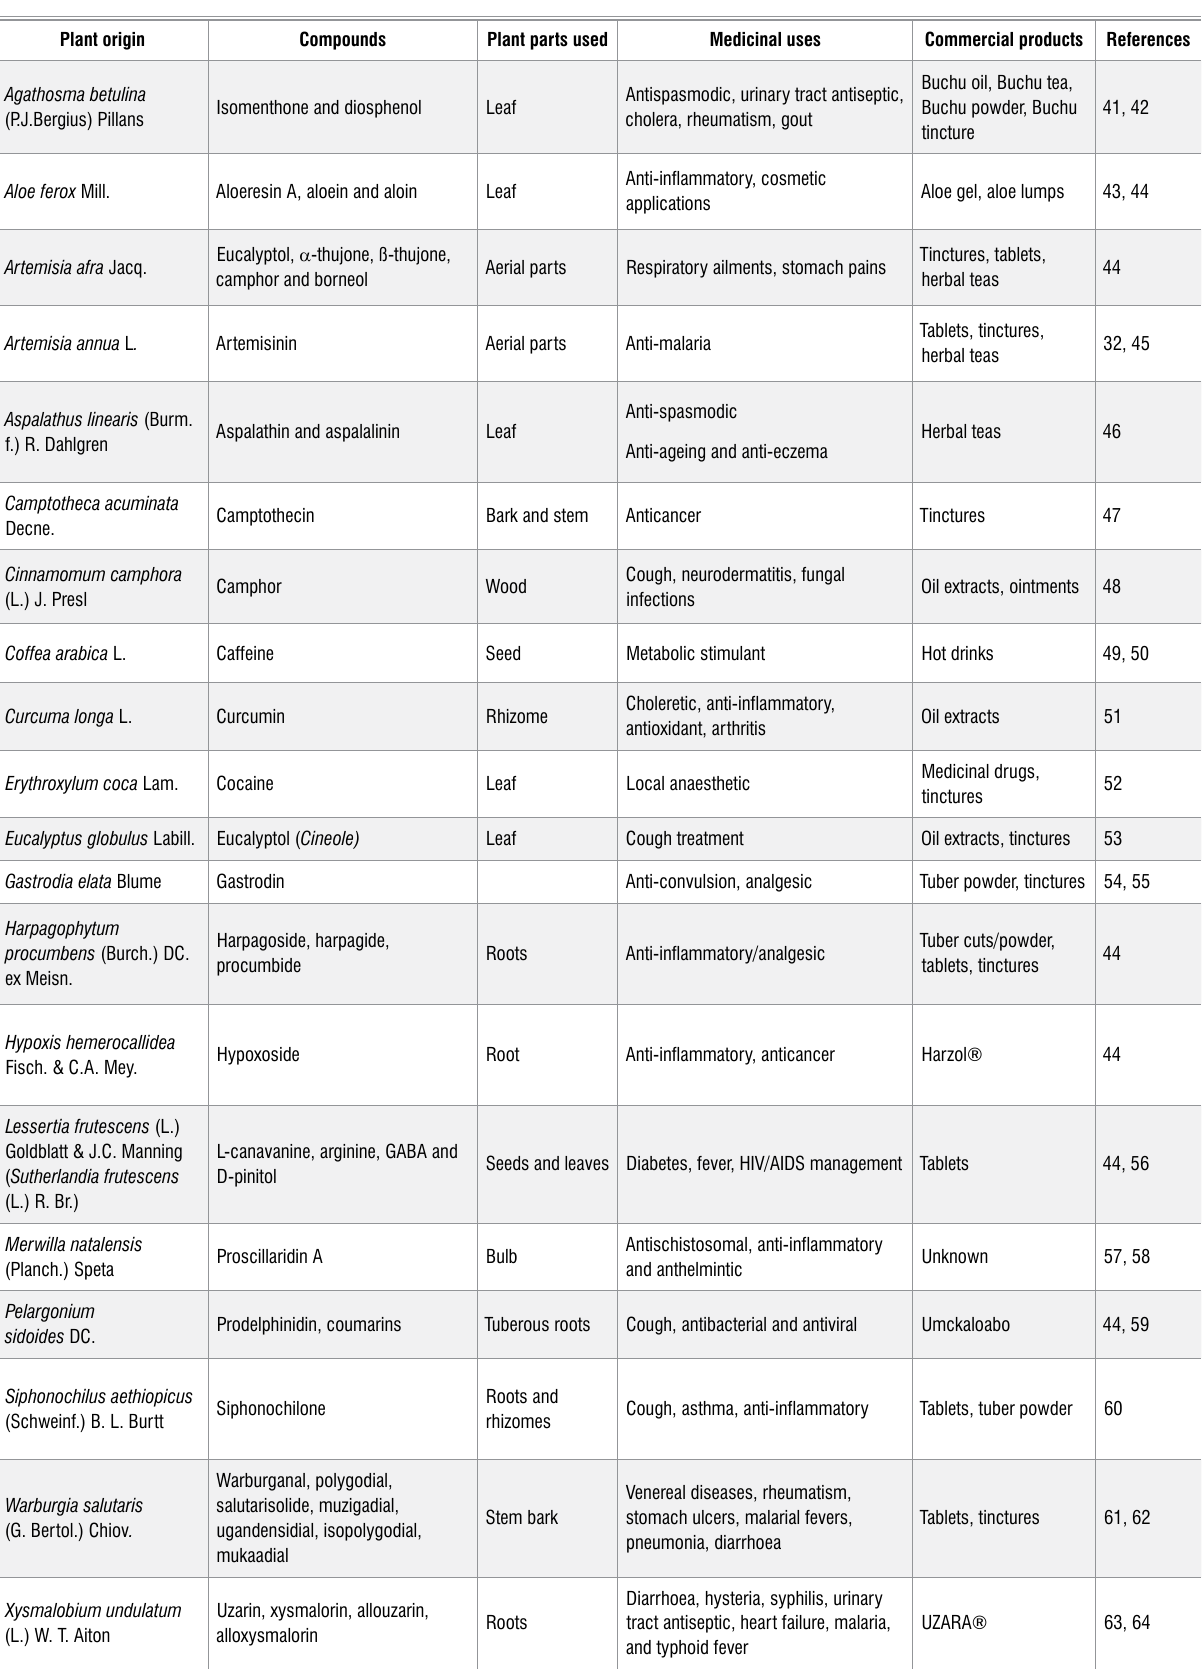
Table 1: Selected medicinal plants and compounds isolated from their different parts for medicinal use Plant